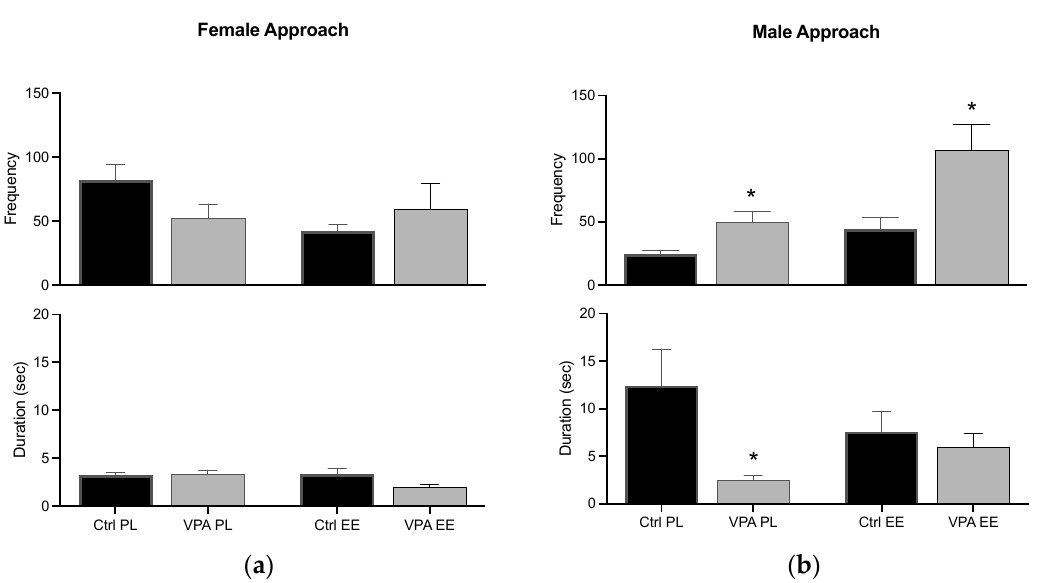
Figure 4. Appetitive behavior. The graph shows how often the female ( a ) and male ( b ) approached each other (frequency), and how long they stayed near each other before withdrawing (duration). Data show the mean ± SEM. * = p < 0.05.